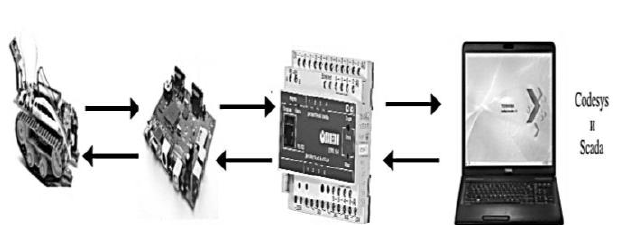
Figure 7. Functional diagram of mobile robot